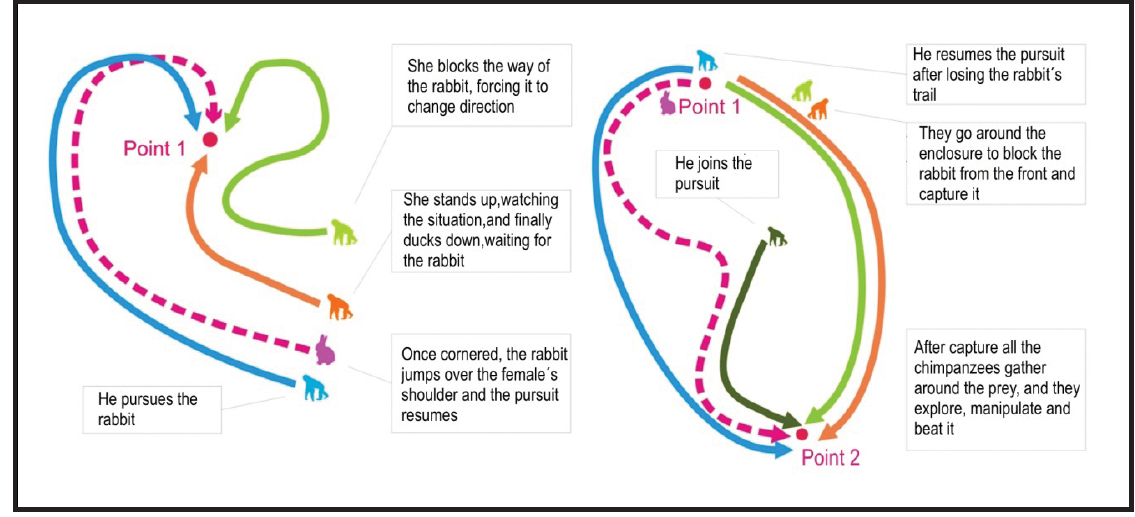
Figure 1. The hunting strategy employed by the FM chimpanzees during the H1 episode.